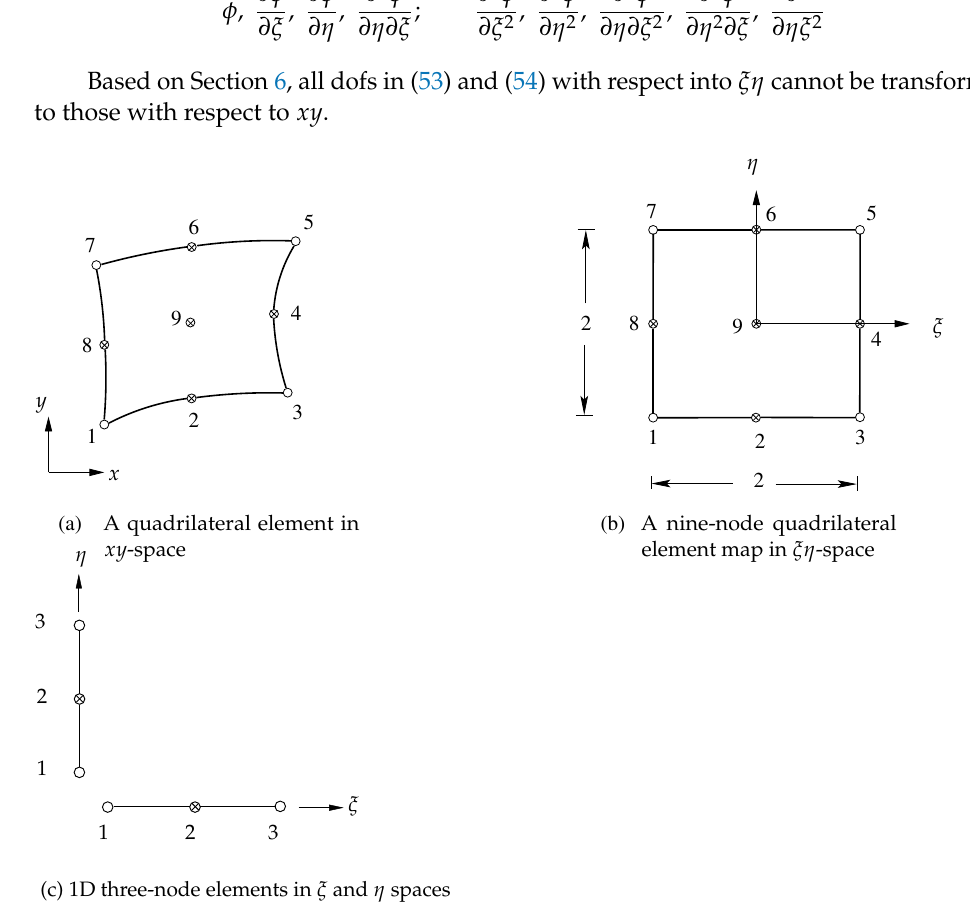
Figure 9. Mapping of nine-node bi-quadratic element in ( x , y )-space into ( ξ , η